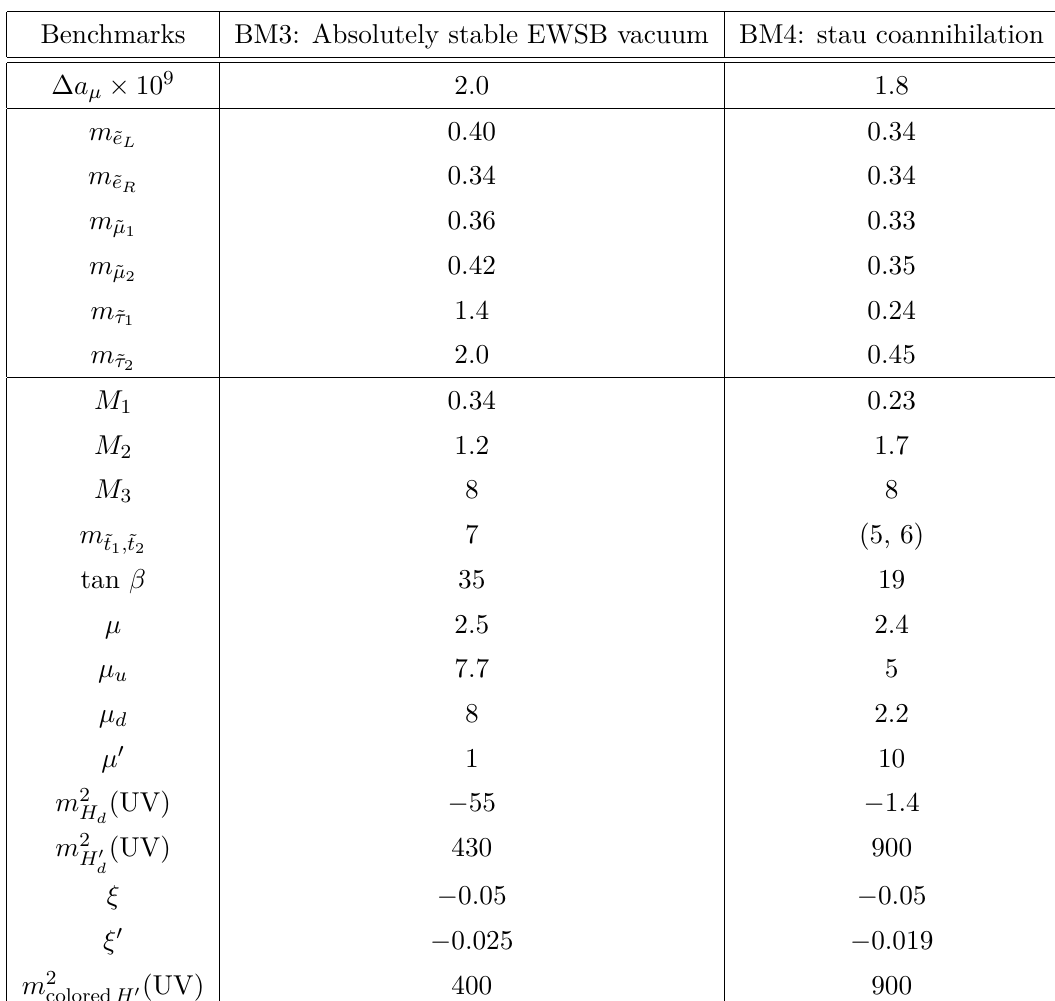
Table 2 . Benchmark model parameters for the non-minimal model. All quantities of mass dimensions are in units of TeV (2) . In the first benchmark (BM3), the potential has no deeper minimum